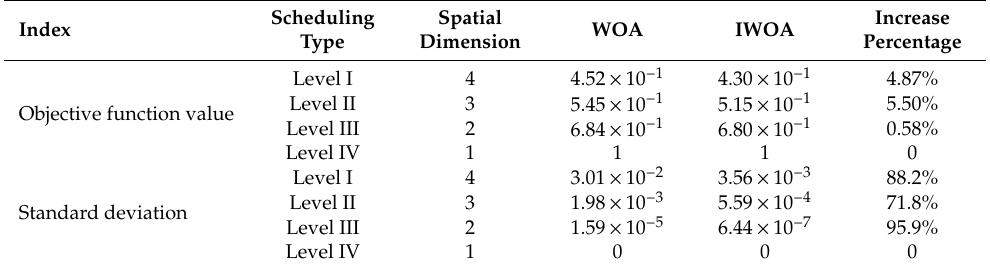
Table 5. Comparison of simulation results before and after algorithm improvement.